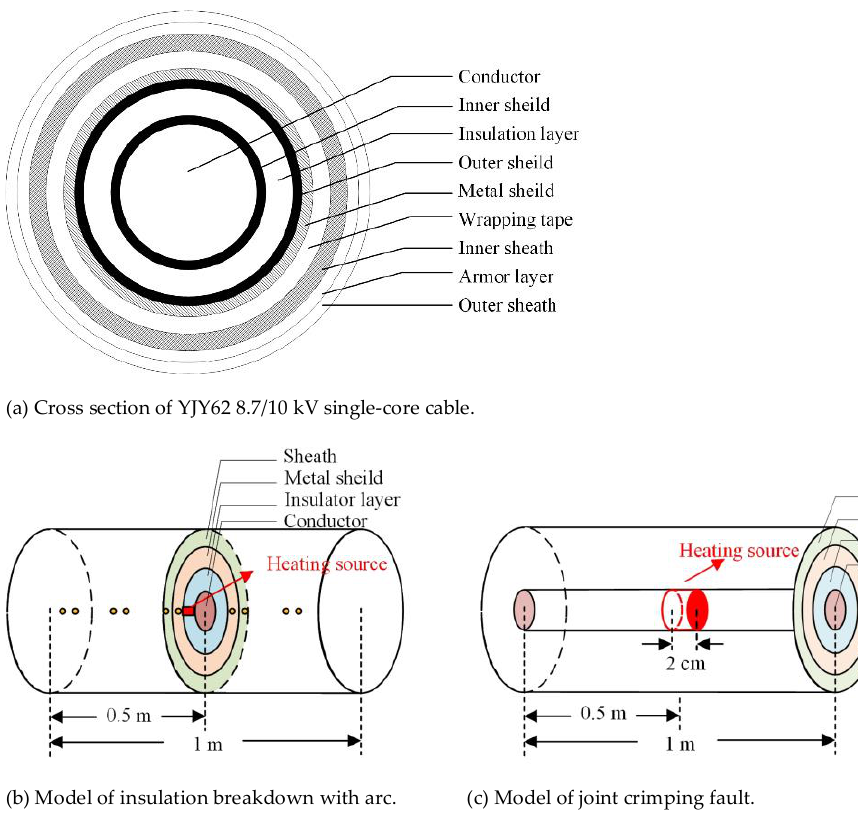
Figure 3. The model of the cable. ( a ) is a cross section of a specific type of cable. ( b ) is an established partial model with a total length of 1 m, the thermal effect of the arc discharge is simplified as a line-shaped heat source located at the insulation layer, which is marked as a red zone, and the thermal insulation condition is adopted at both ends of the model. ( c ) is an established partial model with a total length of 1 m, the thermal effect of the poor crimping is simplified as a cylinder heat source located at the conducting part, and the thermal insulation condition is adopted at both ends of the model. Table 1. Parameters of each layer of the cable.